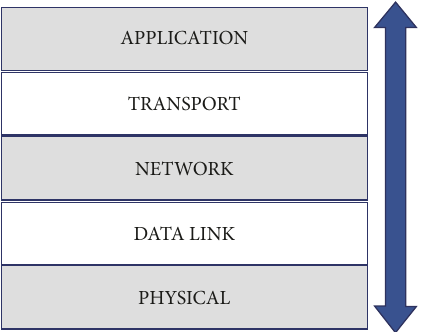
Figure 1: Conceptual diagram of cross layer optimization.